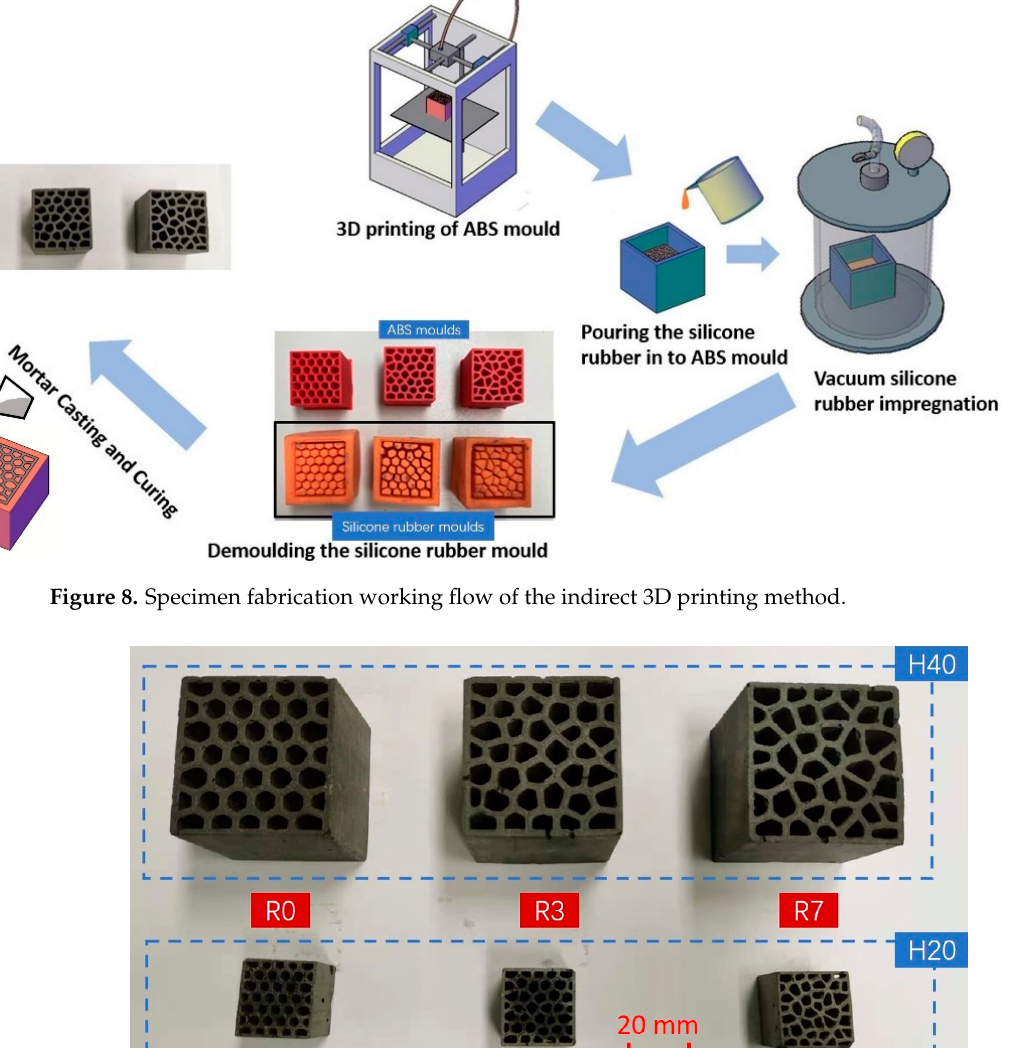
Figure 9. Casted cementitious cellular